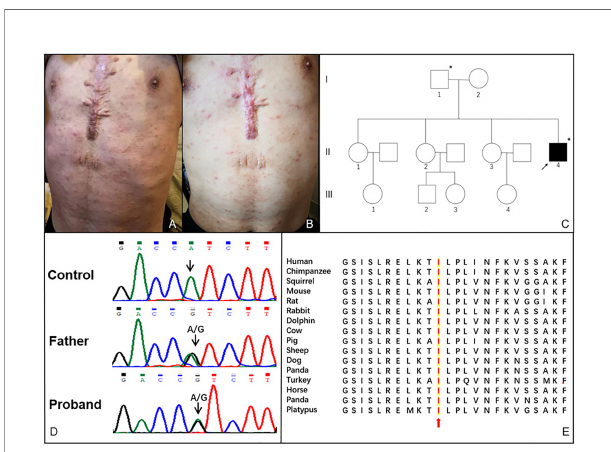
FIGURE 2 | Skin lesion and arthritis of the Chinese patient with APLAID. (A) The lump under the left knee; (B, C) . The ulceration which was diagnosed as gangrenous pyoderma got worse. (D) Ulceration healing after dressing changing and adalimumab treatment. (E) Bone marrow erosion of the knee on MRI. (F) Skin biopsy of the ulceration. The arrow indicates perivascular lymphocyte in fi ltration.